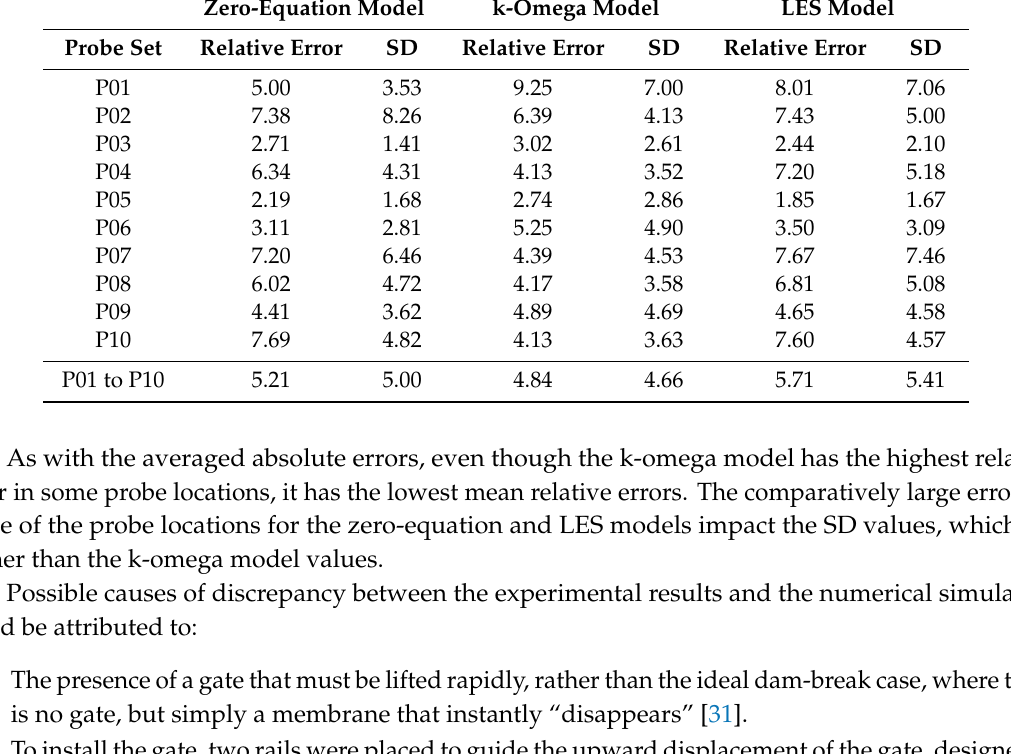
Figure 12. Time series of spatial mean relative error of the three turbulence models.